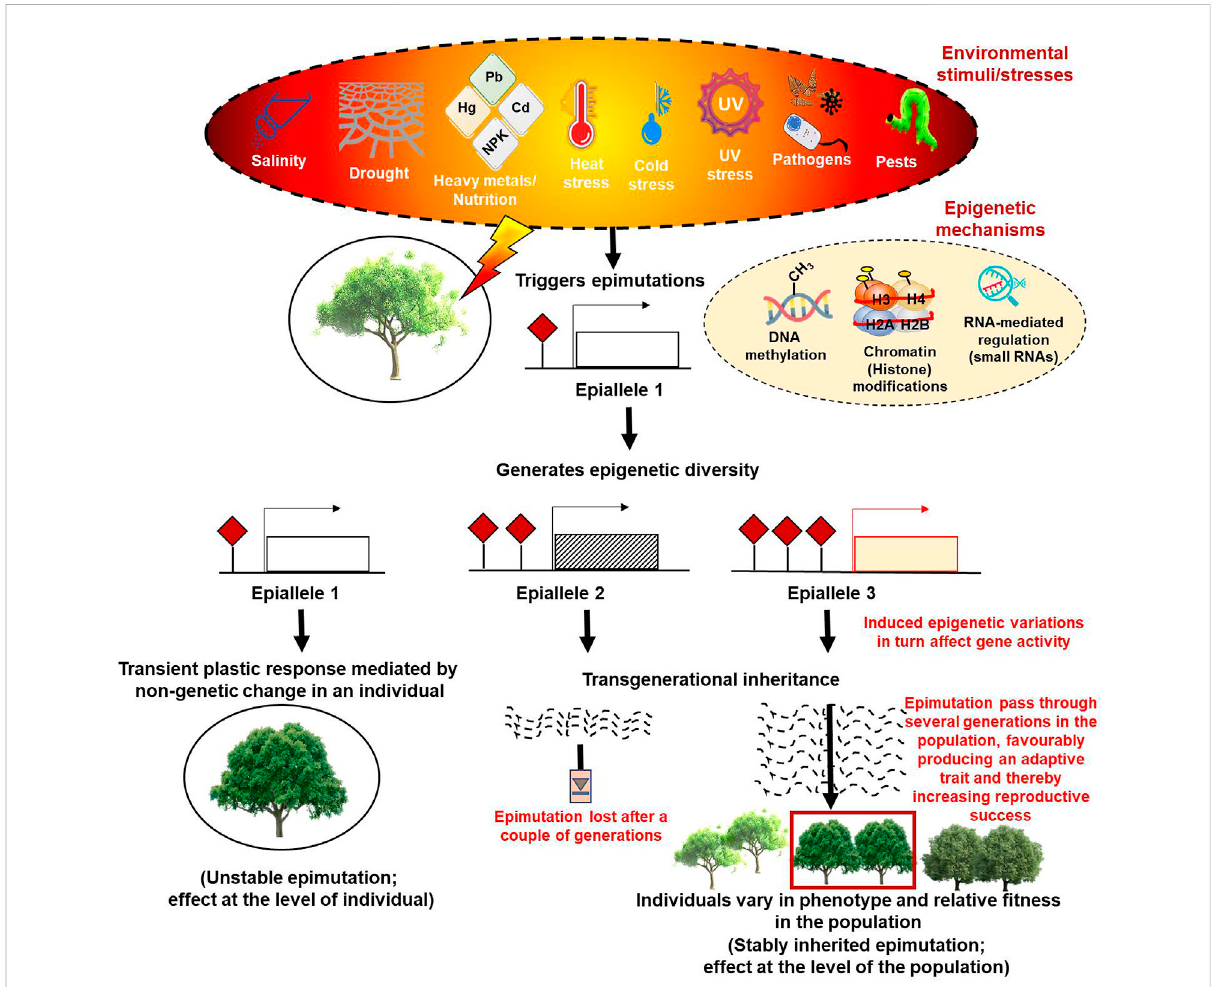
FIGURE 1 Diagrammatic representation of the epigenetic modi fi cations based on their plastic or adaptive response to various environmental cues.